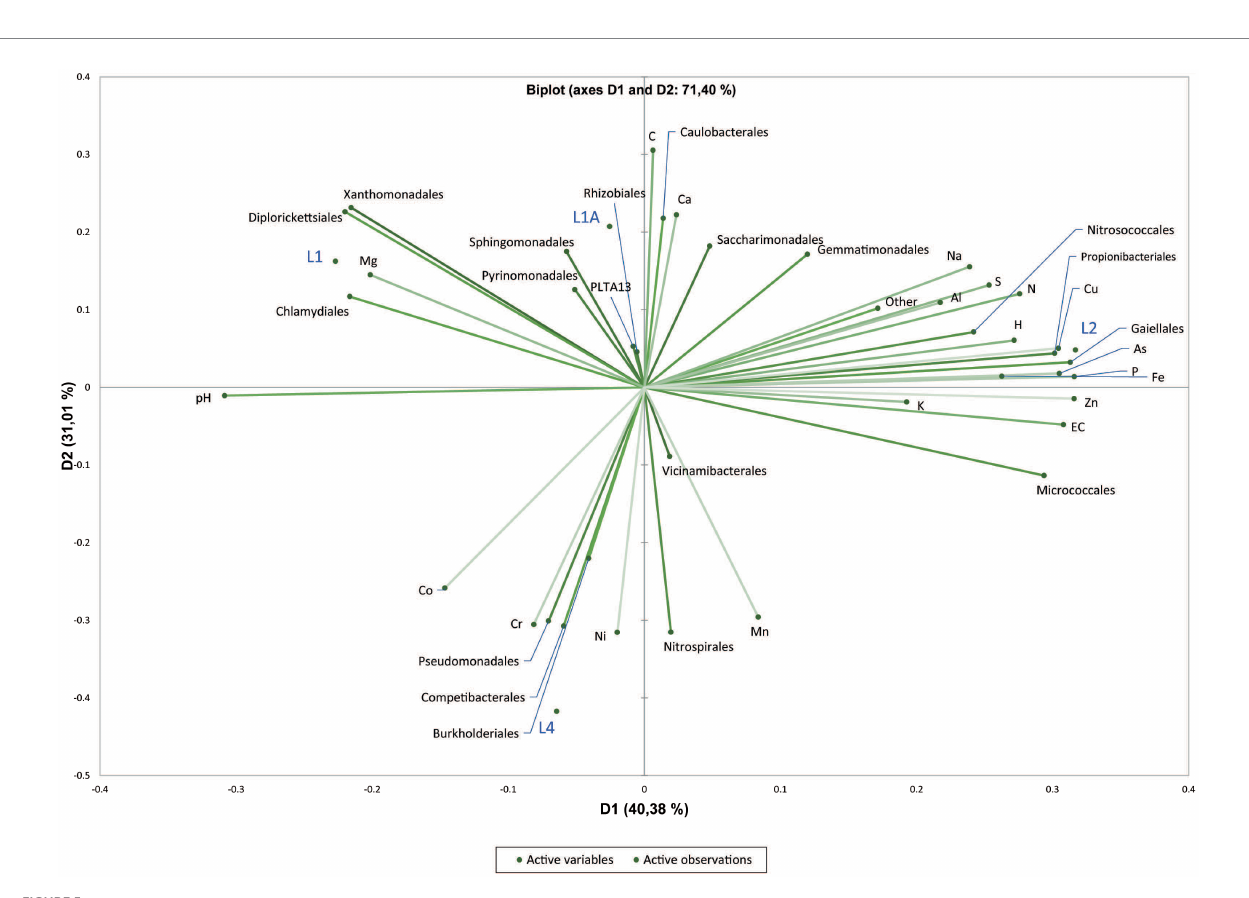
FIGURE 5 Principal Component Analysis (PCA) plot showing correlation between physicochemical factors of sediment samples with the dominant bacterial